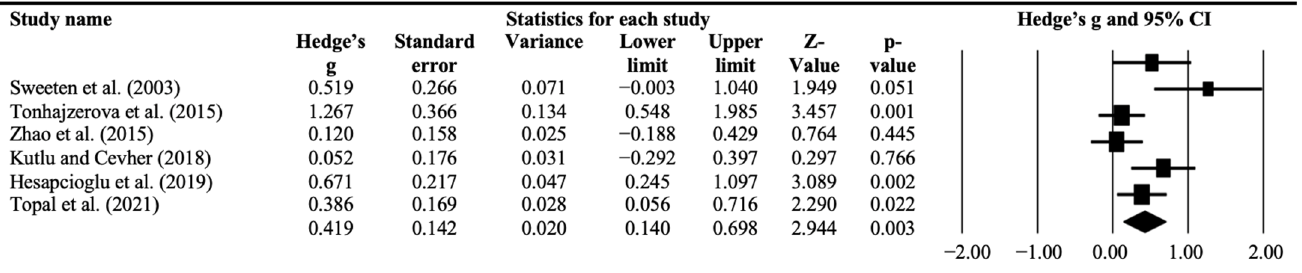
Figure 2. Forest plot of cross-sectional comparisons of blood monocyte levels between medication- naïve individuals with ASD and TD controls. Study name [22,31,32,38,39,46].